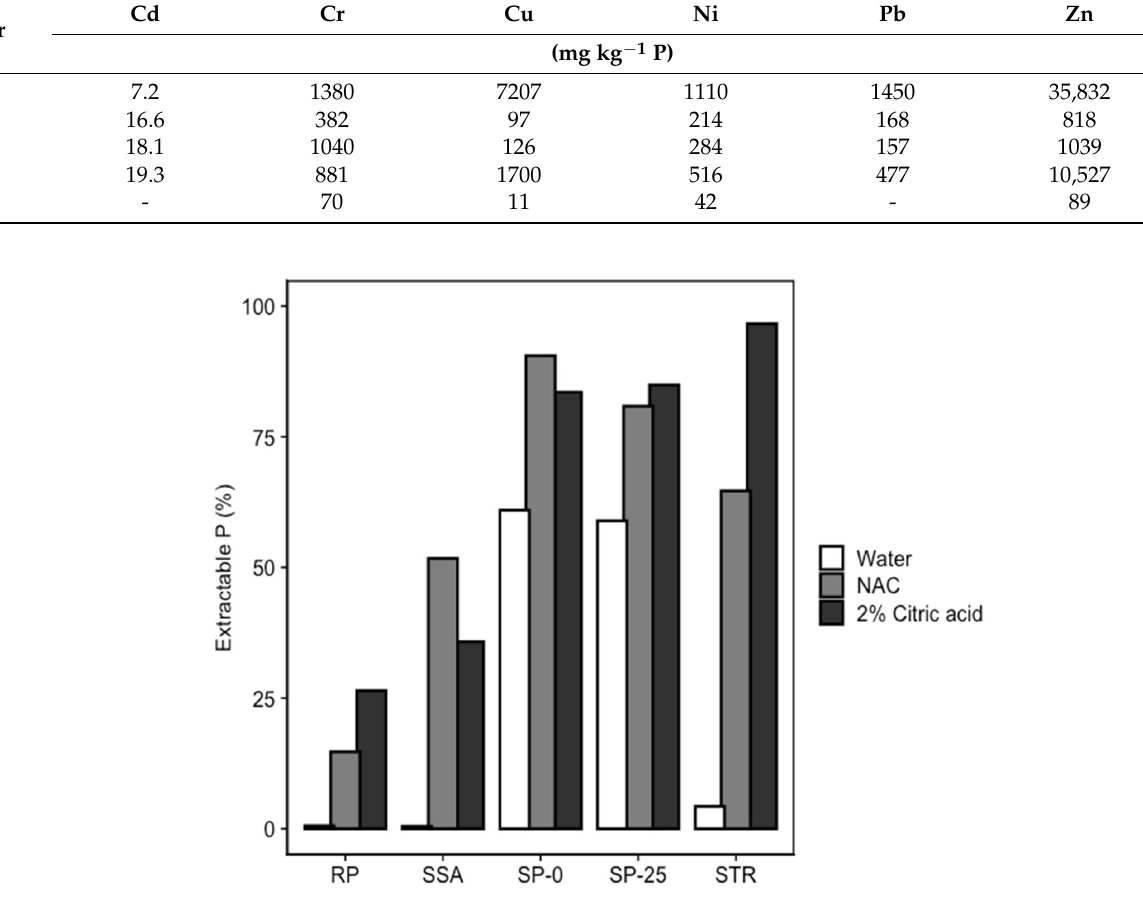
Figure 1. Phosphorus (P) extracted (% of total P) with water, 2% citric acid and neutral ammonium citrate (NAC). For fertilizer abbreviations, see Table